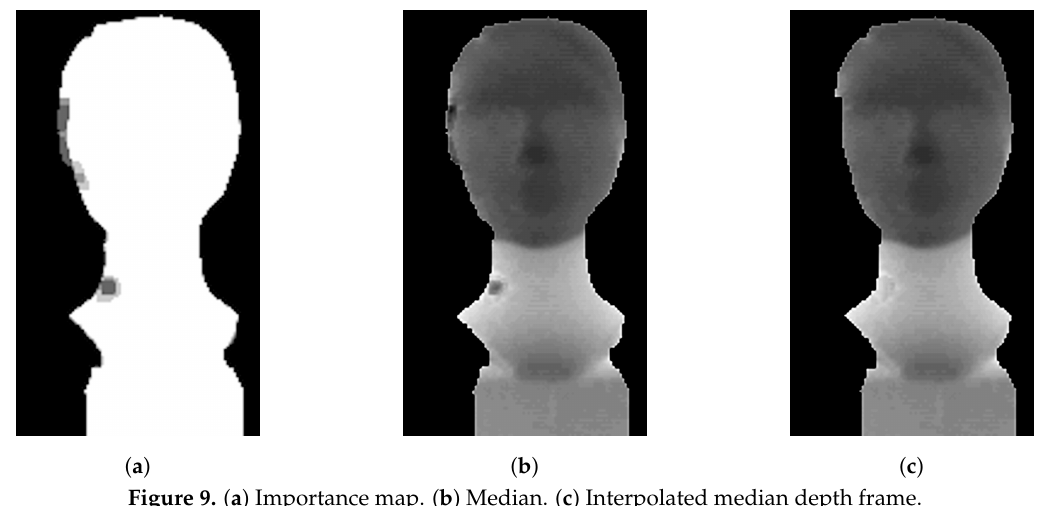
Figure 9. ( a ) Importance map. ( b ) Median. ( c ) Interpolated median depth